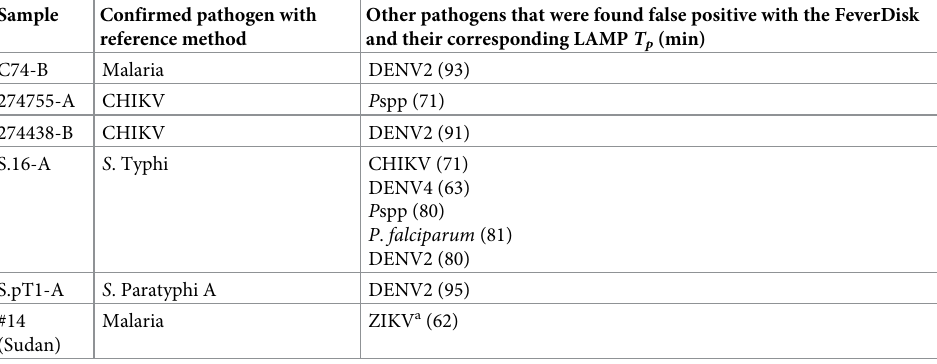
Table 4. FeverDisk false positive results. The results are considered as such, when the T p values are higher than those that were specified, i.e. T p > 44 min for the Plasmodium assays; T p > 60 min for the bacterial assays; T p > 64 min for the CHIKV, DENV viral